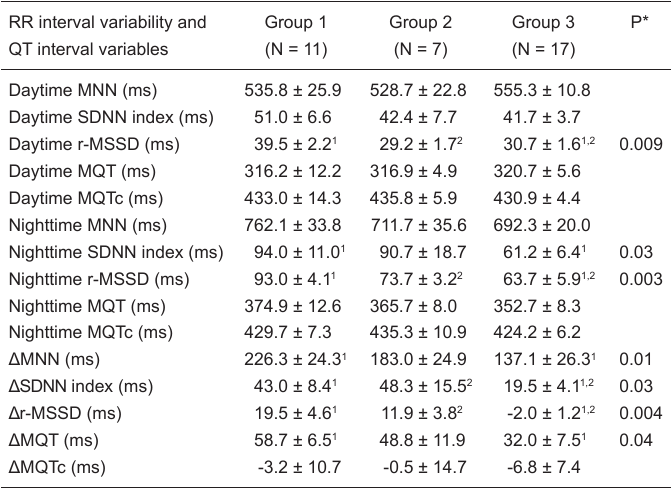
Table 1. Twenty-four-hour RR-interval variability, and 24-h QT interval pa- rameters of the pediatric patients studied. RR interval variability